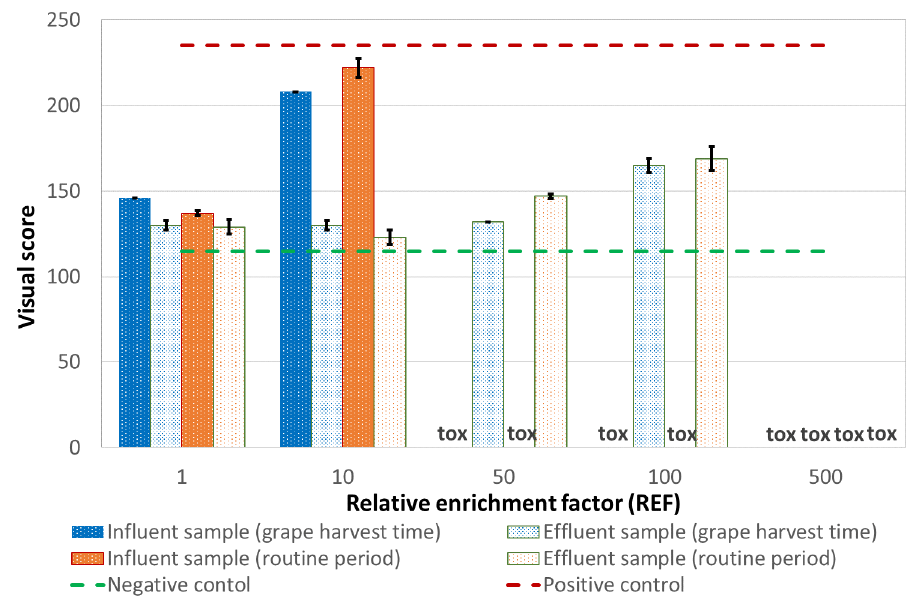
Figure 8. Visual classification of DNA damage, expressed as “visual score”, at increasing concentration. The error bars show the standard deviation.